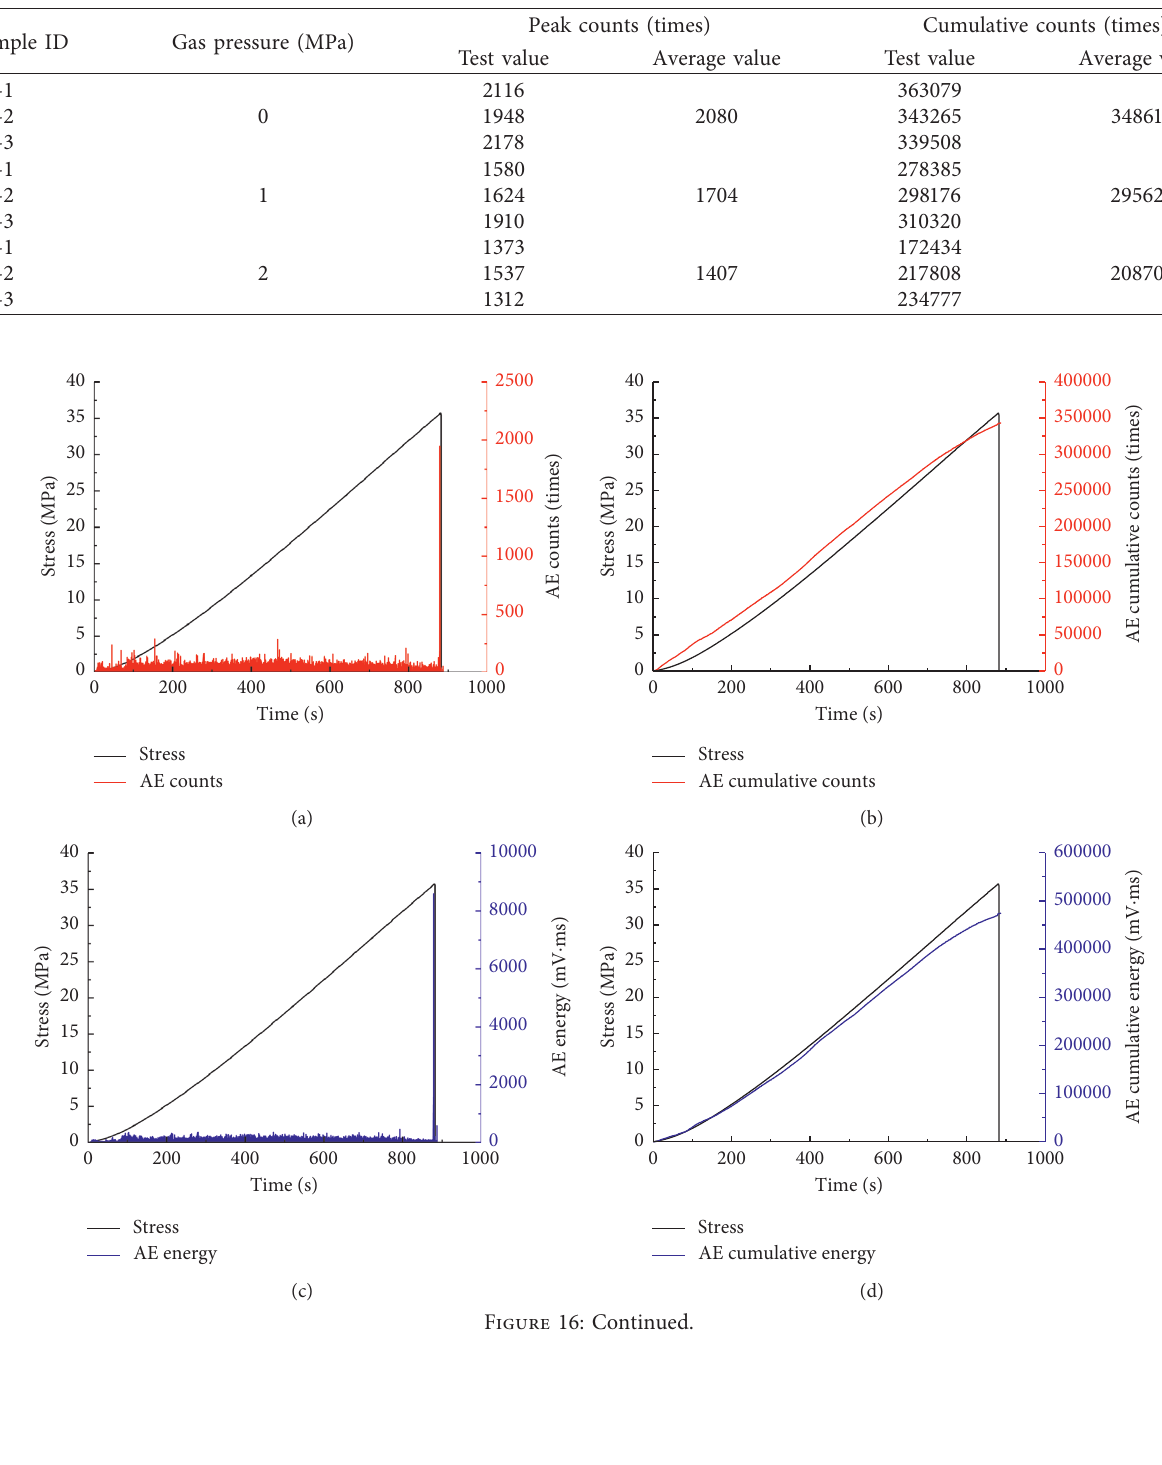
Table 6: AE signal of coal samples with different gas pressures under uniaxial